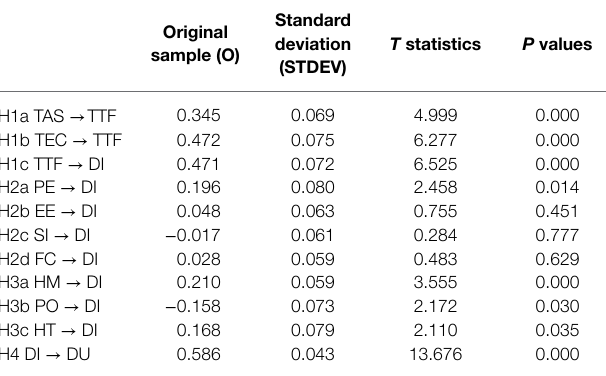
TABLE 7 | Regression weights among the proposed relationships.